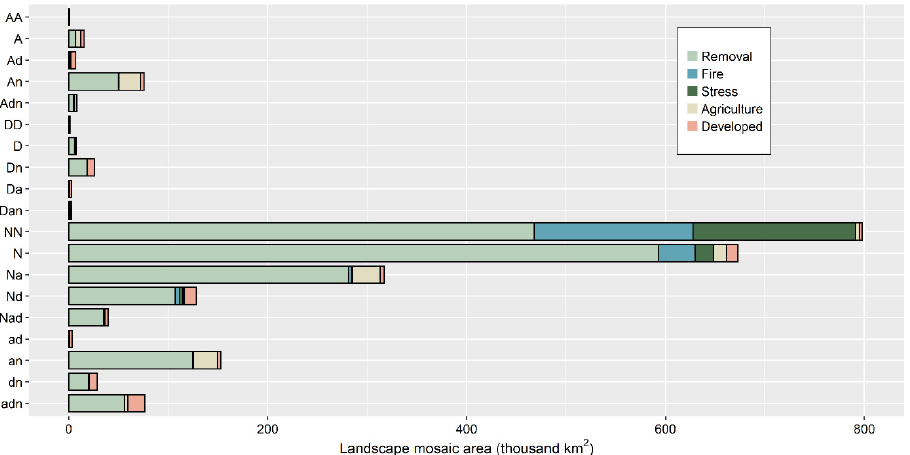
Figure 5. Landscape mosaic class area in 2001 that was exposed to five types of forest change processes in a surrounding 4.41 ha neighborhood by 2011. The types of change are not mutually exclusive; i.e., a given neighborhood may contain more than one type of change. Excludes area that was water in 2001. Table 3. CONUS shares of landscape mosaic area in 2001 that were exposed to five types of change processesinasurrounding4.41haneighborhoodby2011. Changesarenotmutuallyexclusive; i.e., a given neighborhood may contain more than one type of change. Excludes area that was water in 2001.